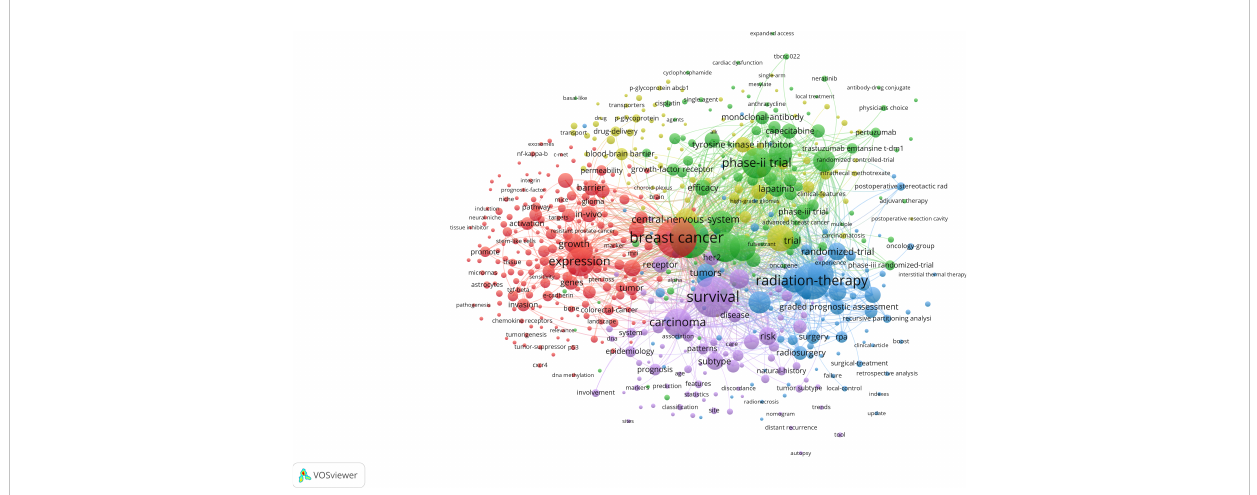
FIGURE 7 Co-occurrence analysis of keywords during 2006 – 2022. Lines between two keywords mean the two words coexisted for more than 10 times. The bigger the node, the more frequent it appears. The stronger the line, the more co-occurrences happen. At least 50 keywords are contained in one cluster. Additionally, keywords connected more closely are divided into the same cluster with the same color. From: VOSviewer.